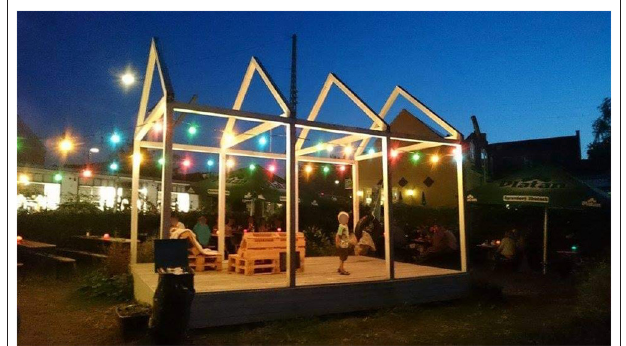
FIGURE 1 | “Valby Pavillon - TH Bar”, a temporary urban project in Copenhagen, Denmark. A vacant urban site (a former auto repair shop) was activated for communal uses through a temporary pavilion, a pop-up container bar, a herb garden and an exchange station. The place existed as a popular destination in the neighborhood until housing construction activities took over the site. TH Bar and its activities are in the process of relocating to a new site in the neighborhood. Credit: Pavilion and project initiation: Bettina Lamm, Anne Wagner and Kristian Skaarup in collaboration with Valby Lokaludvalg (Valby local government committee). TH Bar developed by Nima Alijani. Photo: Bettina